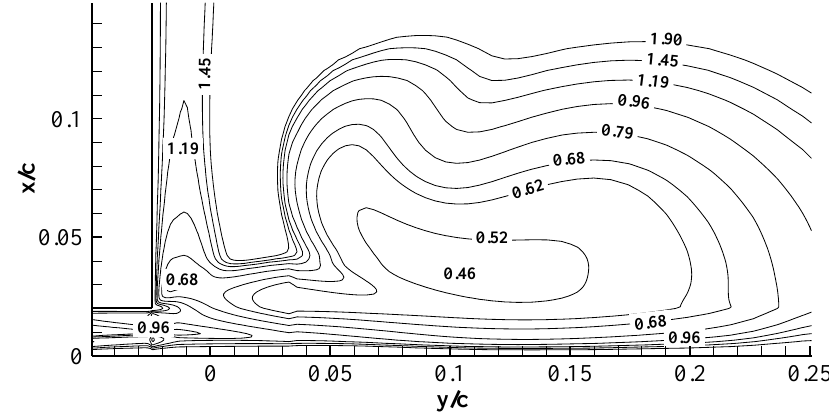
Figure 3. The ratio of the grid size ∆ to the lengthscale l EI at at z / c = 0.3. The mesh size used for the present study is 150 × 255 × 300. As shown in Figure 4, the meshes are clustered around the tip gap, blade pressure and suction surfaces, and end-wall to ensure appropriate resolution in the region of primary interest. There are 31 mesh points allocated across the tip-gap region for with a tip-gap size of 0.02 c . Based on the chord in the spanwise, pitchwise, and streamwise directions, the grid spacings are 6.7 × 10 −4 ≤ ∆𝑥/𝑐 ≤ 5.5 × 10 −2 , 5 × 10 −4 ≤ ∆𝑦/𝑐 ≤ 5 × 10 −2 , and 5.8 × 10 −3 ≤ ∆𝑧/ 𝑐 ≤ 6.5 × 10 −2 , respectively. The growth factor of the mesh around the tip-gap and blade surface is limited to a range of 1.0~1.2. The values of y + varies due to different velocity magnitude, ranging from 0.3 to 19 with an average value of 3.4. ( b ) Figure 4. Meshing computational domain: ( a ) global mesh, and ( b ) local region A.